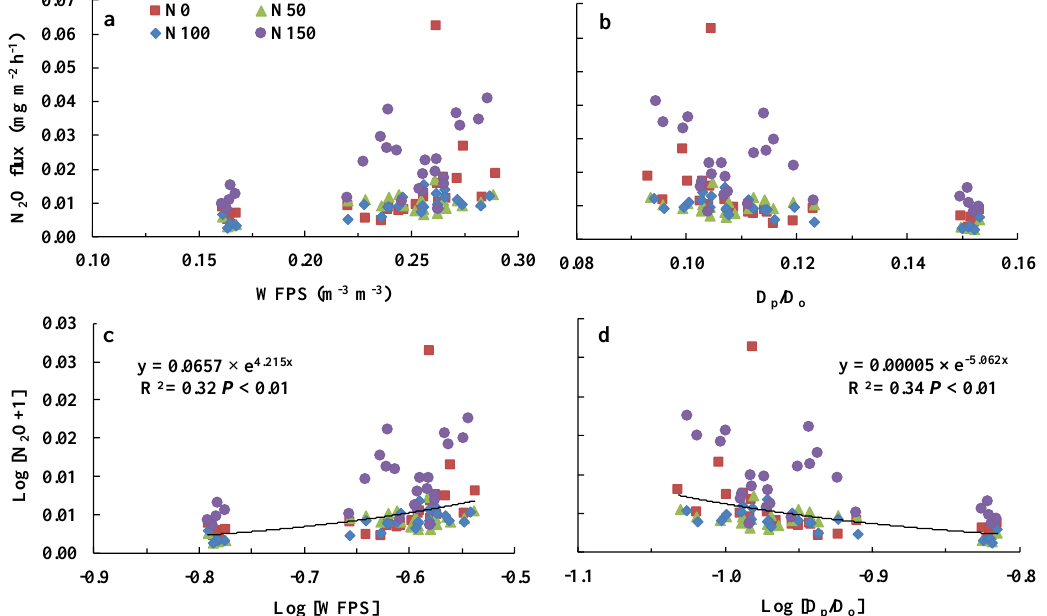
Figure 6. Mean N 2 O emission and ( a ) water-filled pore space (WFPS) and ( b ) relative soil diffusivity ( D p /D o ); Exponential regression of mean Log [N 2 O + 1] and ( c ) Log [WFPS] or ( d ) Log [ D p /D o ] from four nitrogen addition treatments, data points are individual replicates ( n = 3).